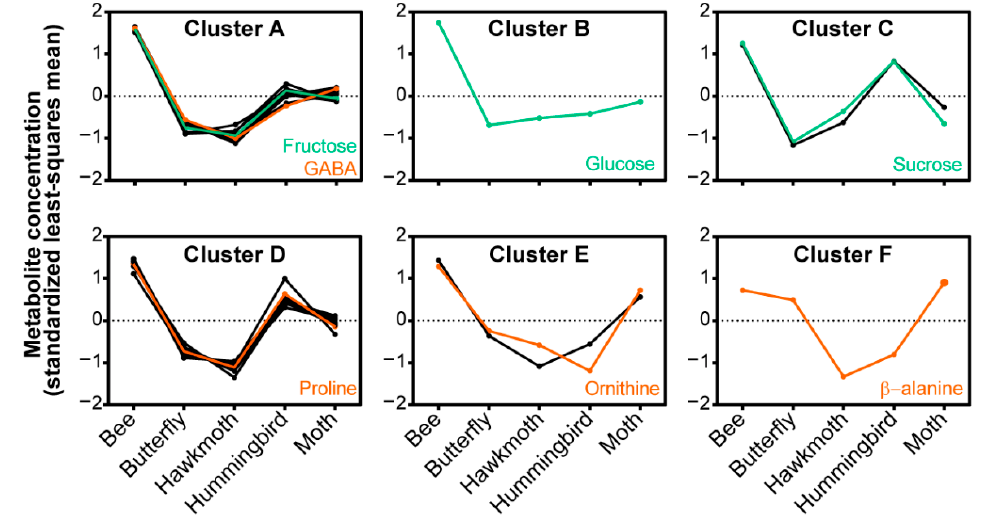
Figure 6. Nectar metabolites clustered by preferred pollinator. Hierarchical clustering analysis of the 27 quantified nectar metabolites grouped by preferred pollinator. Sugars are highlighted in green and phagostimulatory amino acids are highlighted in orange.